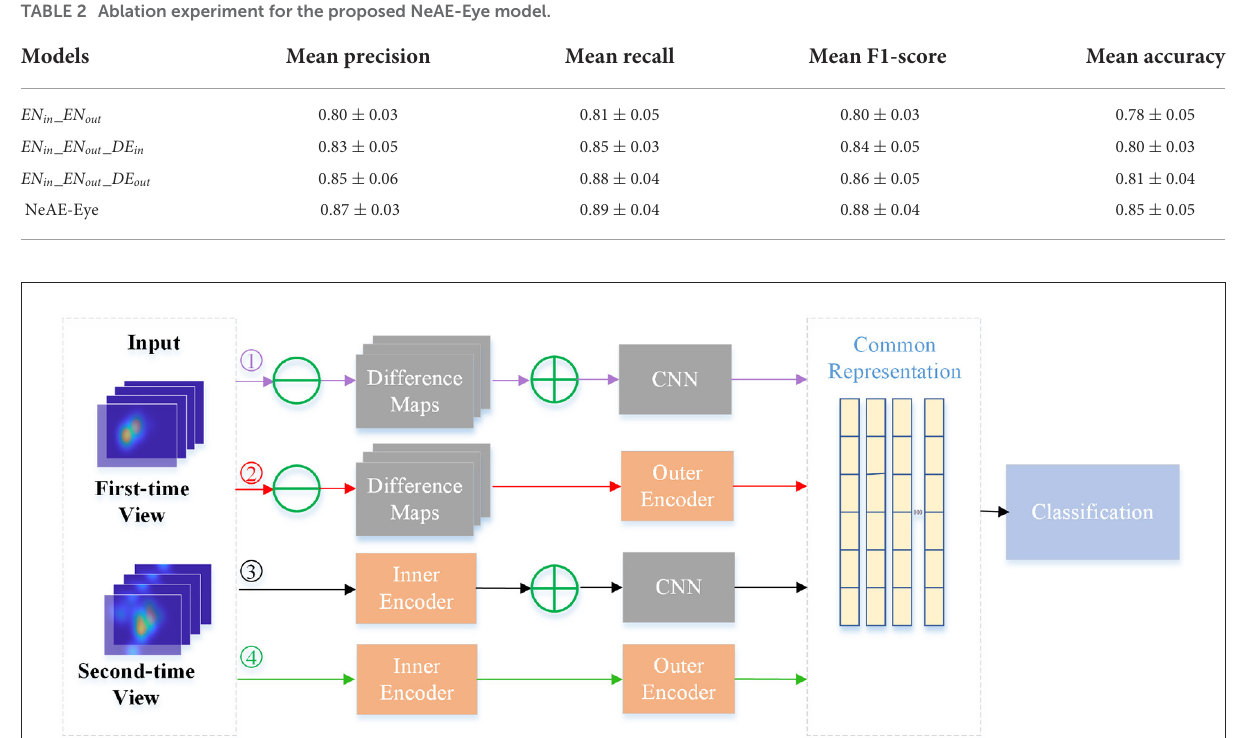
FIGURE8 Flowchart of four different models for comparison. The four branches are: Model1 (Difference maps with CNN), Model2 (Difference maps with outer autoencoder), Model3 (Inner autoencoder with CNN) and Model4 (Inner autoencoder with outer autoencoder).